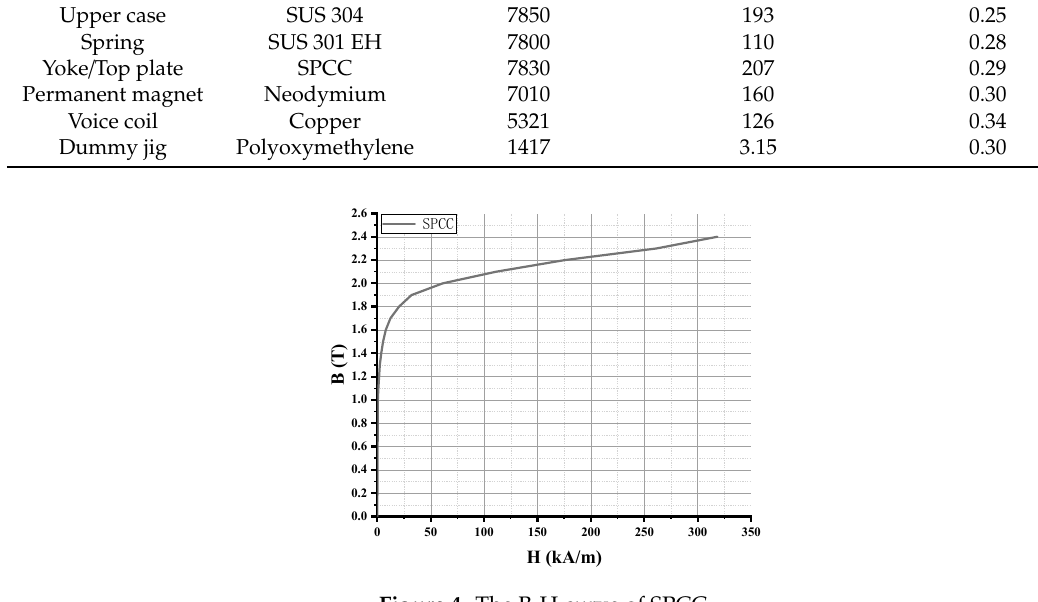
Figure 4. The B-H curve of SPCC.